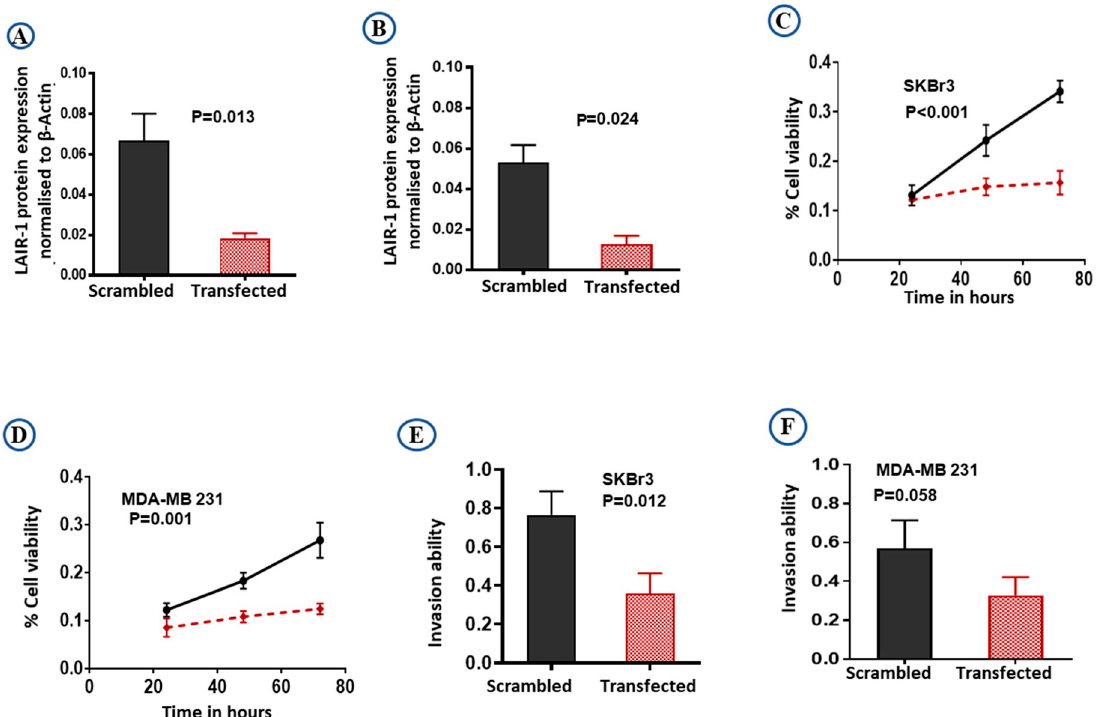
Figure 5. Downregulation of LAIR-1 expression by siRNA transfections. SKBr3 and MDA-MB 231 cells were transfected with scrambled control siRNA or LAIR-1 siRNA. Cells were then seeded in duplicate in corresponding media, total cell extracts were collected 72 h after transfection and 20 µg protein aliquots were blotted with LAIR-1 and β -Actin. Results shown are mean ± standard error of the mean (SEM) of three independent experiments. LAIR-1 protein expression normalised to β -Actin showed more than 95% reduction in the LAIR-1 siRNA cells in both ( A ) SKBr3 and ( B ) MDA-MB 231 cells. Cell proliferation was significantly reduced after LAIR-1 siRNA transfection in both BC cell lines ( C ) SKBr3 and ( D ) MDA-MB 231 as detected by MTS assay. LAIR-1 siRNA transfection showed significantly decreased invasion ability in the SKBr3 cells ( E ), while MDA-MB 231 ( F ) showed a similar trend. Results shown are mean ± standard error of the mean (SEM) from three independent transfections.